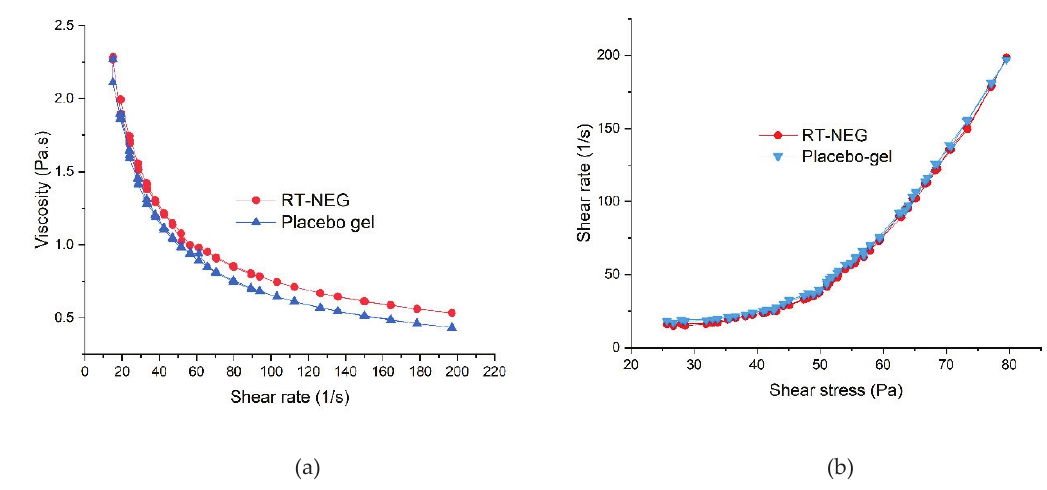
Figure 5. Rheological behavior of the retinyl palmitate-loaded nano-emulgel (RT-NEG) and placebo gel, demonstrating ( a ) viscosity versus shear rate and ( b ) shear rate versus shear stress.